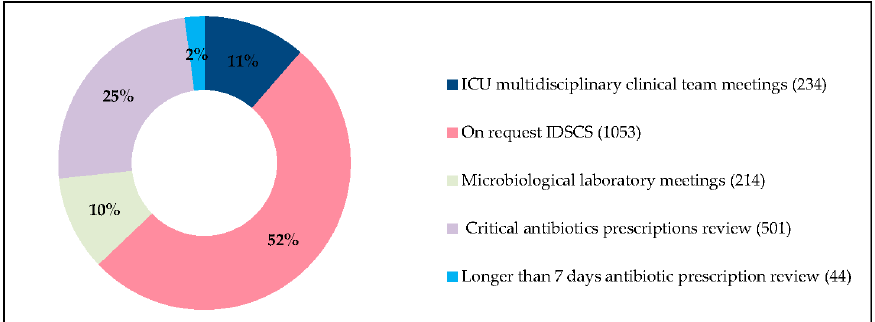
Figure 1. Interventions’ distribution. Distribution of the 2046 interventions noted in the electronic patient record related to 1430 hospital stays and 1243 patients. Abbreviations: ICU, intensive care unit; IDSCS, infectious diseases specialist consulting service .